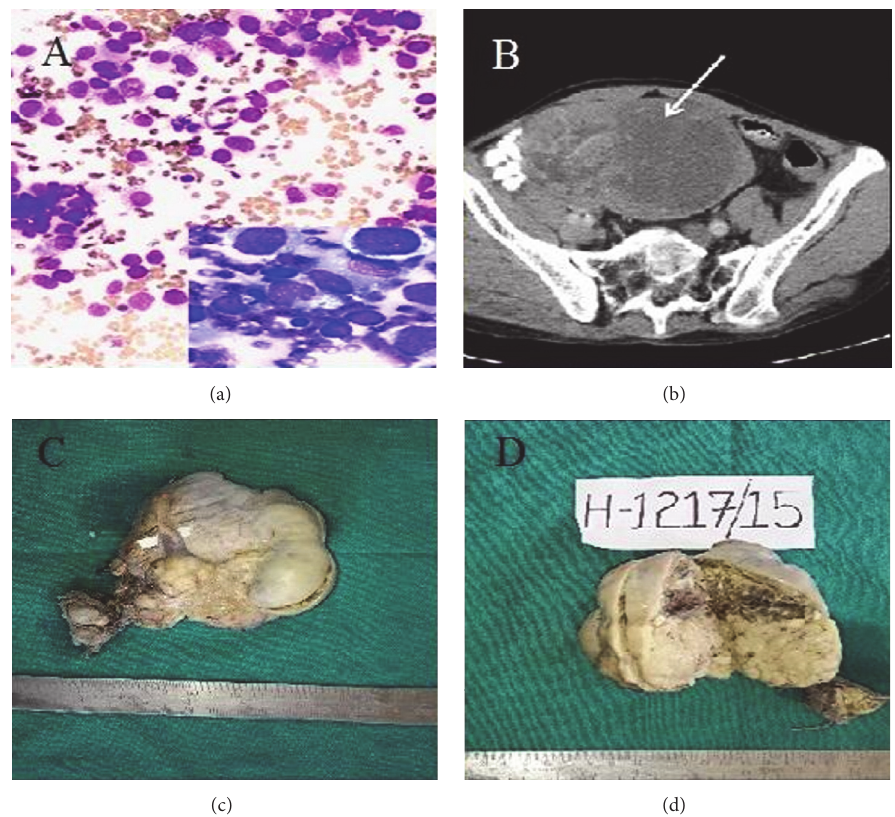
Figure 1: (a) Smear depicting dispersed tumor cells admixed with lymphoplasmacytic infiltrate. (b) CECT depicting heterogeneously enhancing suprapubic and inguinal masses. (c) Gross specimen showing bosselated external surface of the larger mass with attached vas deferens and smooth encapsulated smaller mass. (d) Cut section of masses with more variegated appearance of the larger